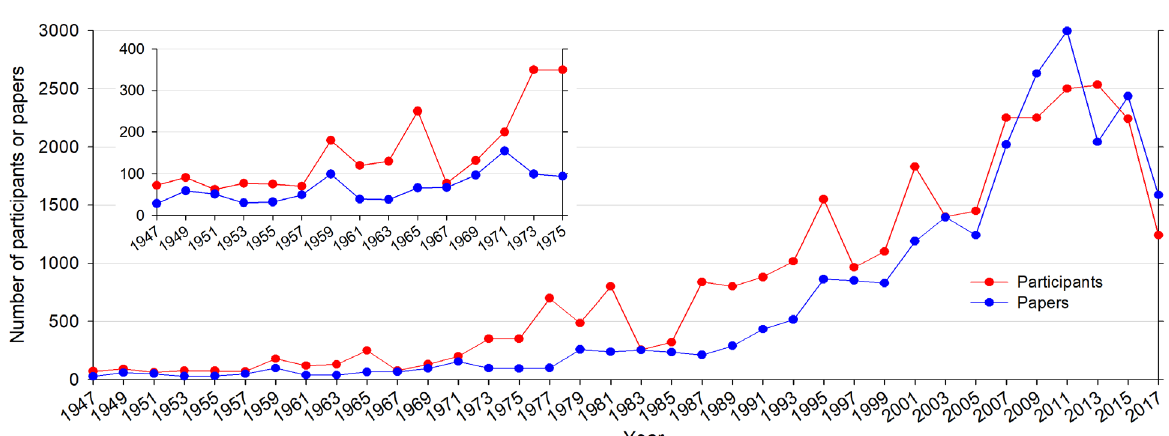
Figure 1. Numbers of participants and papers in each edition of the Brazilian Congress of Soil Science (Congresso Brasileiro de Ciência do Solo - CBCS) between 1947 and 2017. The subfigure highlights the numbers of participants and papers in the editions between 1947 and 1975. Sources: 1947-2013 (Oliveira et al. 2015); 2015-2017 (SBCS 2015a, SBCS